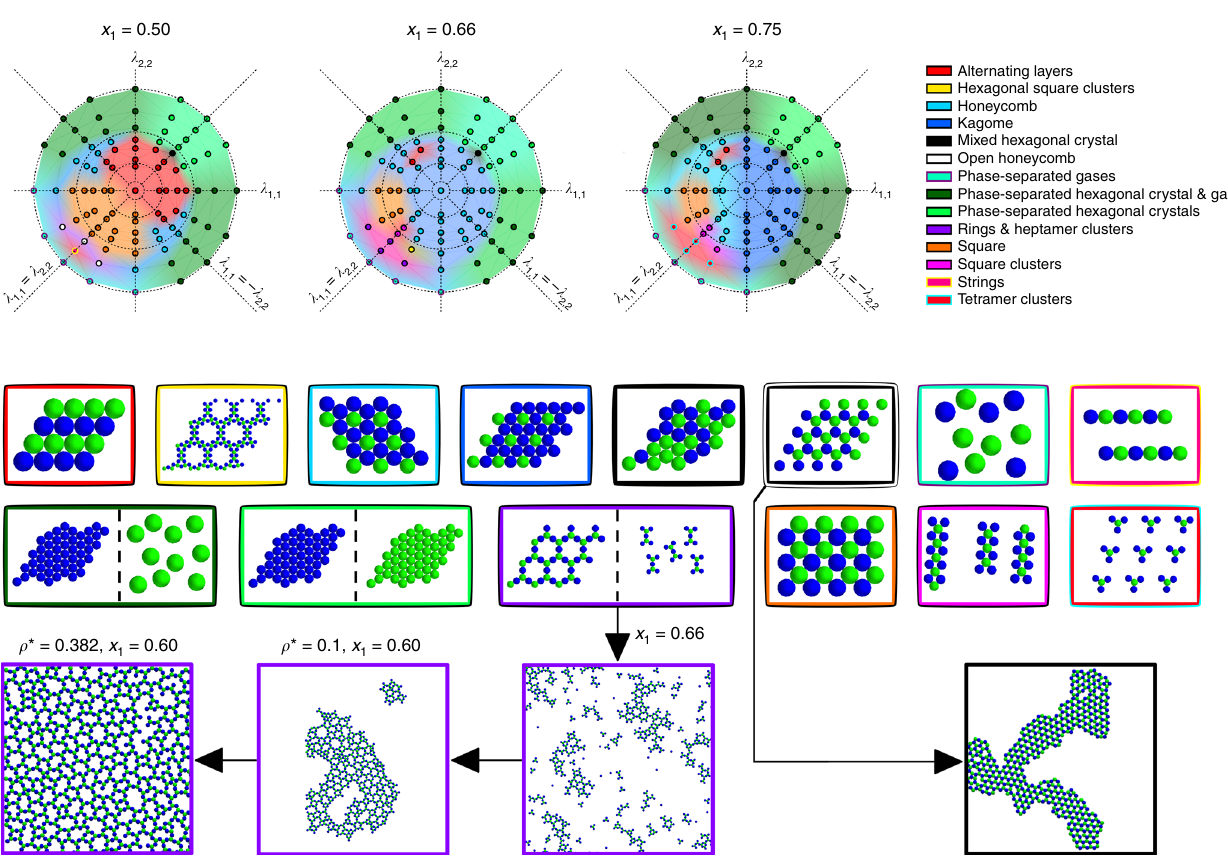
Fig. 5 Thermodynamically stable structures for binary, multi- fl avored colloidal mixtures. Various sets of λ = ( λ 1,1 , λ 1,2 , λ 2,2 ) were explored and mapped to a unit sphere. Only the projection of the hemisphere where λ 1,2 ≥ 0 is shown, where the outermost dashed circle denotes the equator ð λ 1 ; 2 ¼ 0 ; λ 2 and the central point denotes the zenith ( λ 1,2 = 1, λ 1,1 = λ 2,2 = 0). Structures were determined from the phase diagram computed at each λ , and the results are indicated by a color-coded circle for each stoichiometry of species 1 (blue) and species 2 (green) considered. Depictions of the corresponding structures are outlined by the color of the point they correspond to; note that the choice of species coloring (blue vs. green) may be reversed for some regions of the diagram where one species is in excess of the other. The background coloring serves only for visualization purposes to guide the eye. Representative snapshots from molecular dynamics simulations of a few conditions are also depicted at the